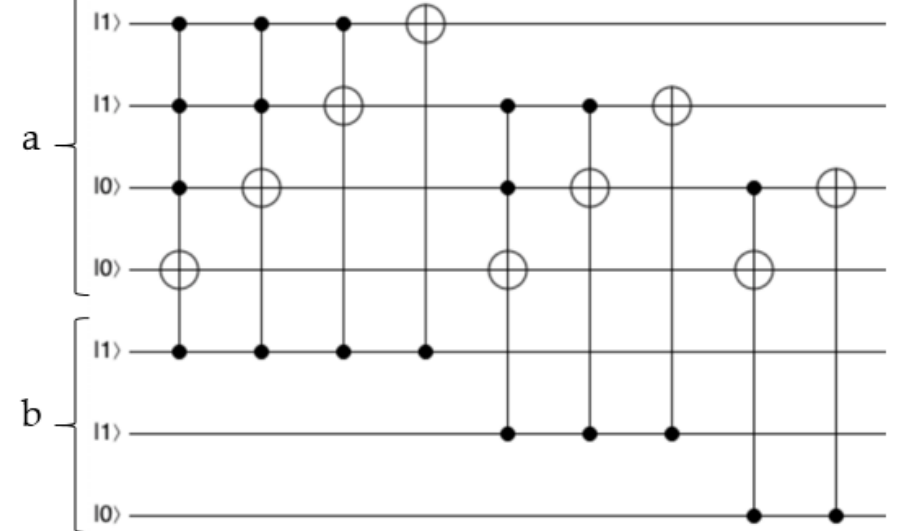
Figure 7. Example of reusable module for adding two numbers represented by the register a and b. Despite it does not include all the elements indicated above, it is a module that fulfils the constraints required to be a module (image obtained using the https://algassert.com tool, accessed on 23 June 2021).